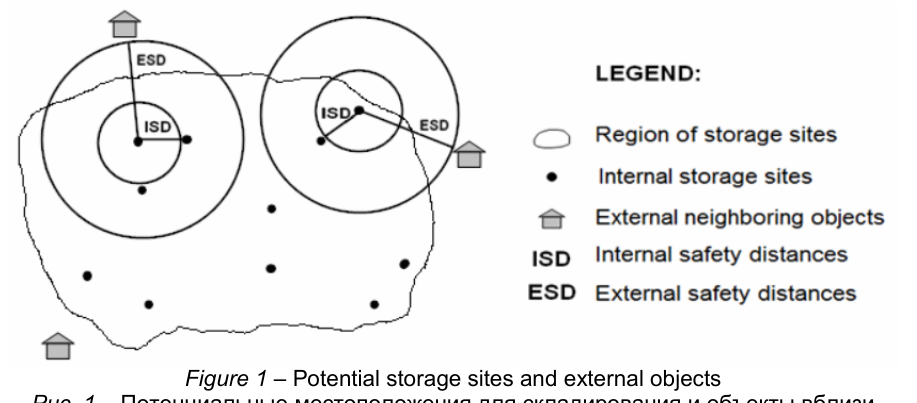
Figure 1 – Potential storage sites and external objects Рис . 1 – Потенциальные местоположения для складирования и объекты вблизи Slika 1 – Potencijalne lokacije skladišta i objekti u njihovoj